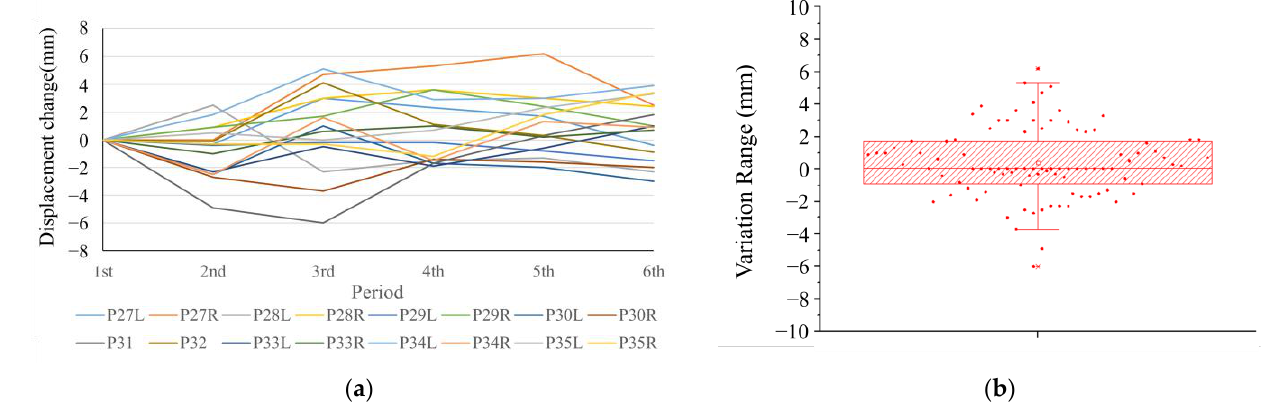
Figure 11. ( a ) Longitudinal inclination changes of piers during the monitoring period; ( b ) variation distribution of longitudinal inclination changes of piers during the monitoring period.